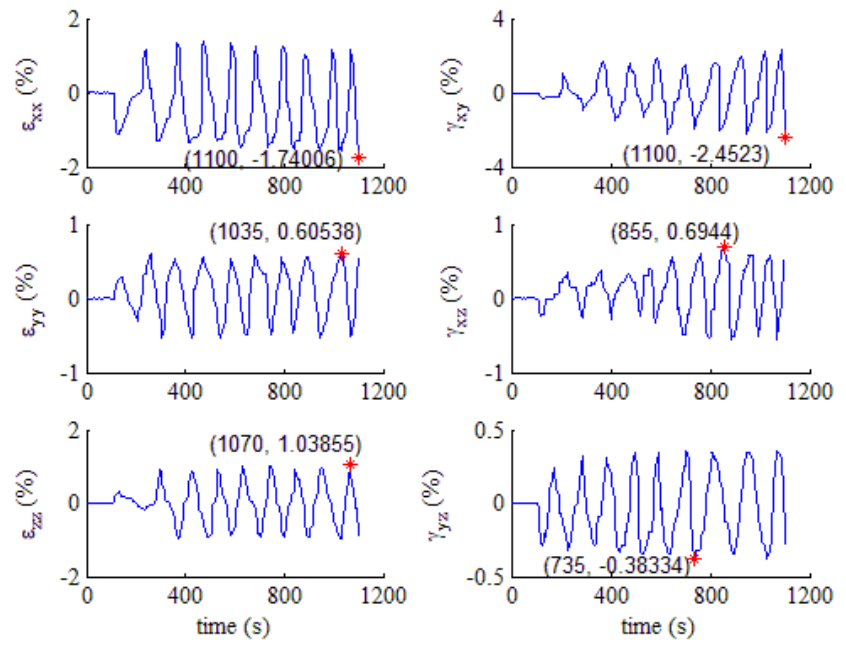
Figure 8. Six strain responses of NWB_2 weld. (* in the figure means the peak or valley of the strain).